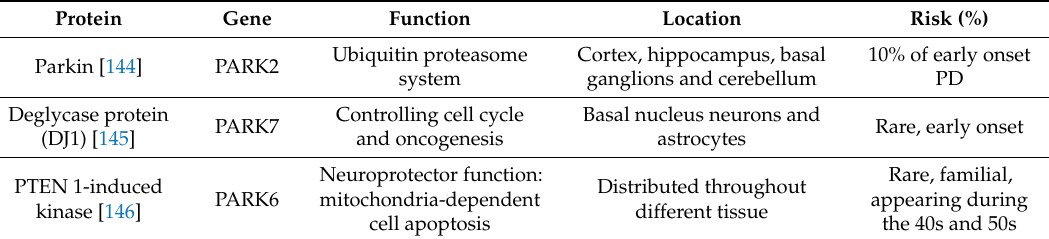
Table 4. Autosomal recessive mutations in PA